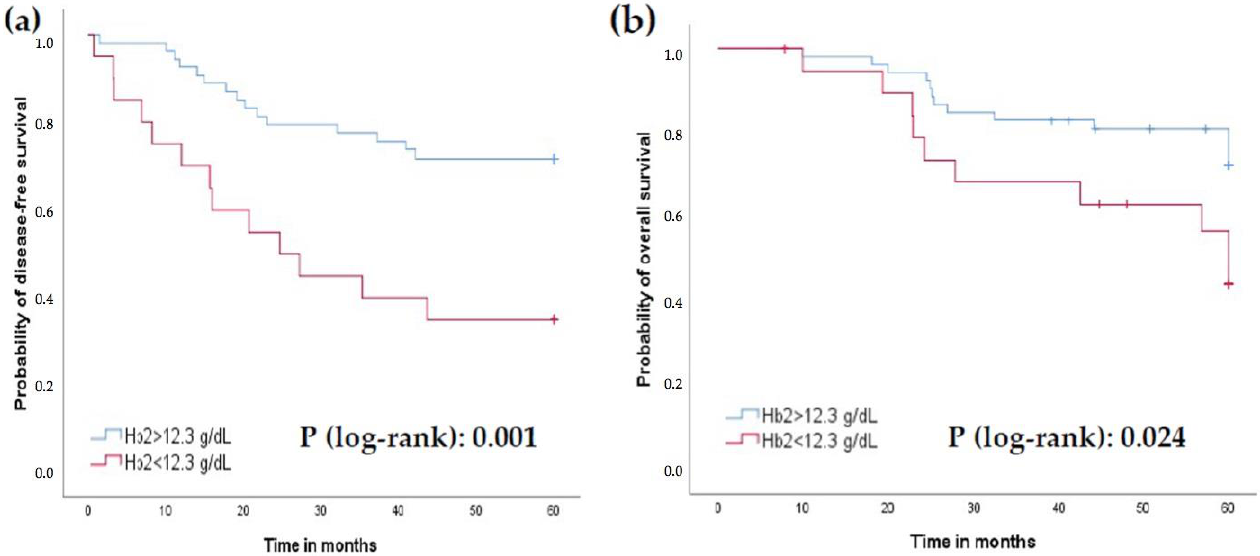
Figure 3. Prognostic role of Hb2 levels with a cut-off value of 12.3 g/dL. ( a ) Progression-free survival (PFS). ( b ) Overall survival (OS).